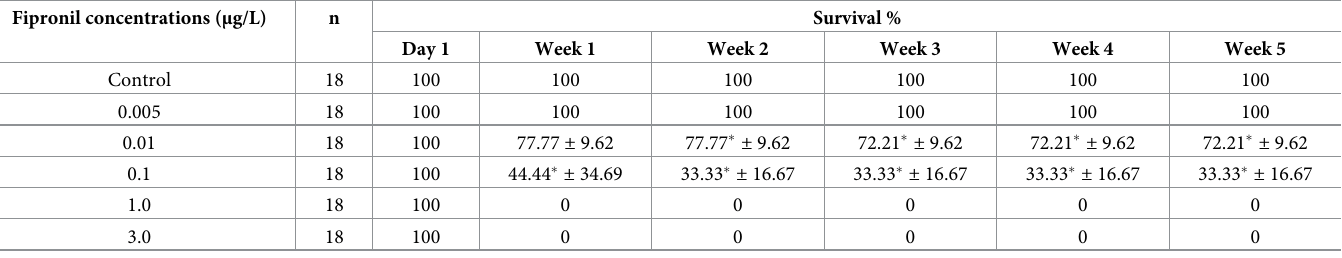
n = number of shrimp individuals in each treatment (6 shrimp per replicate aquarium, 3 aquariums per treatment). Values with star ( � ) indicate treatment is significantly different from the control (P < 0.0001–0.004).